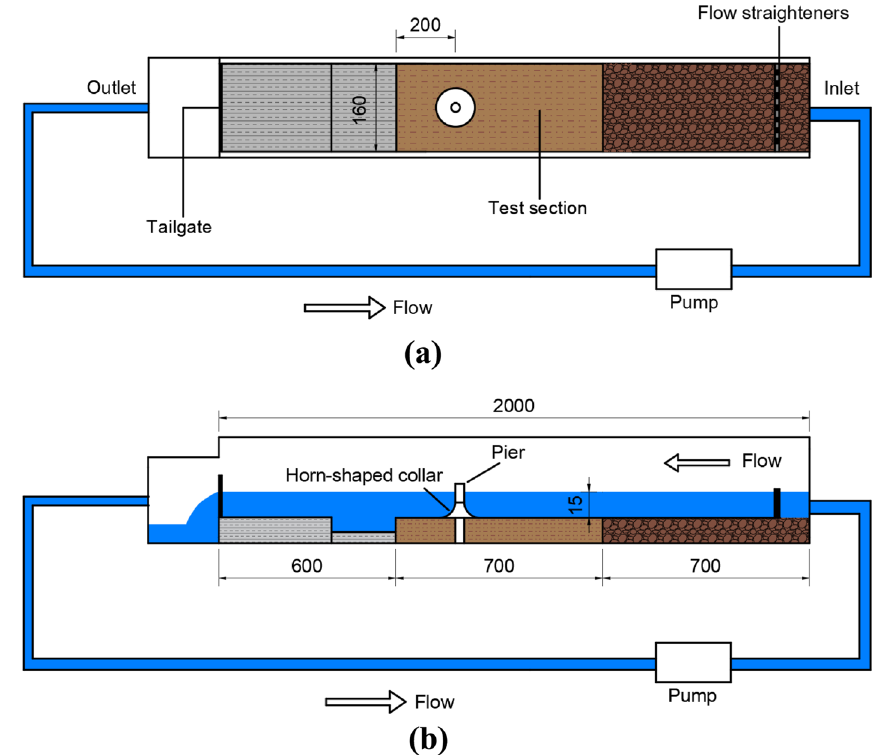
Fig. 2 Schematic diagram of the test flume (unit: cm). a Top view. b Cross-section